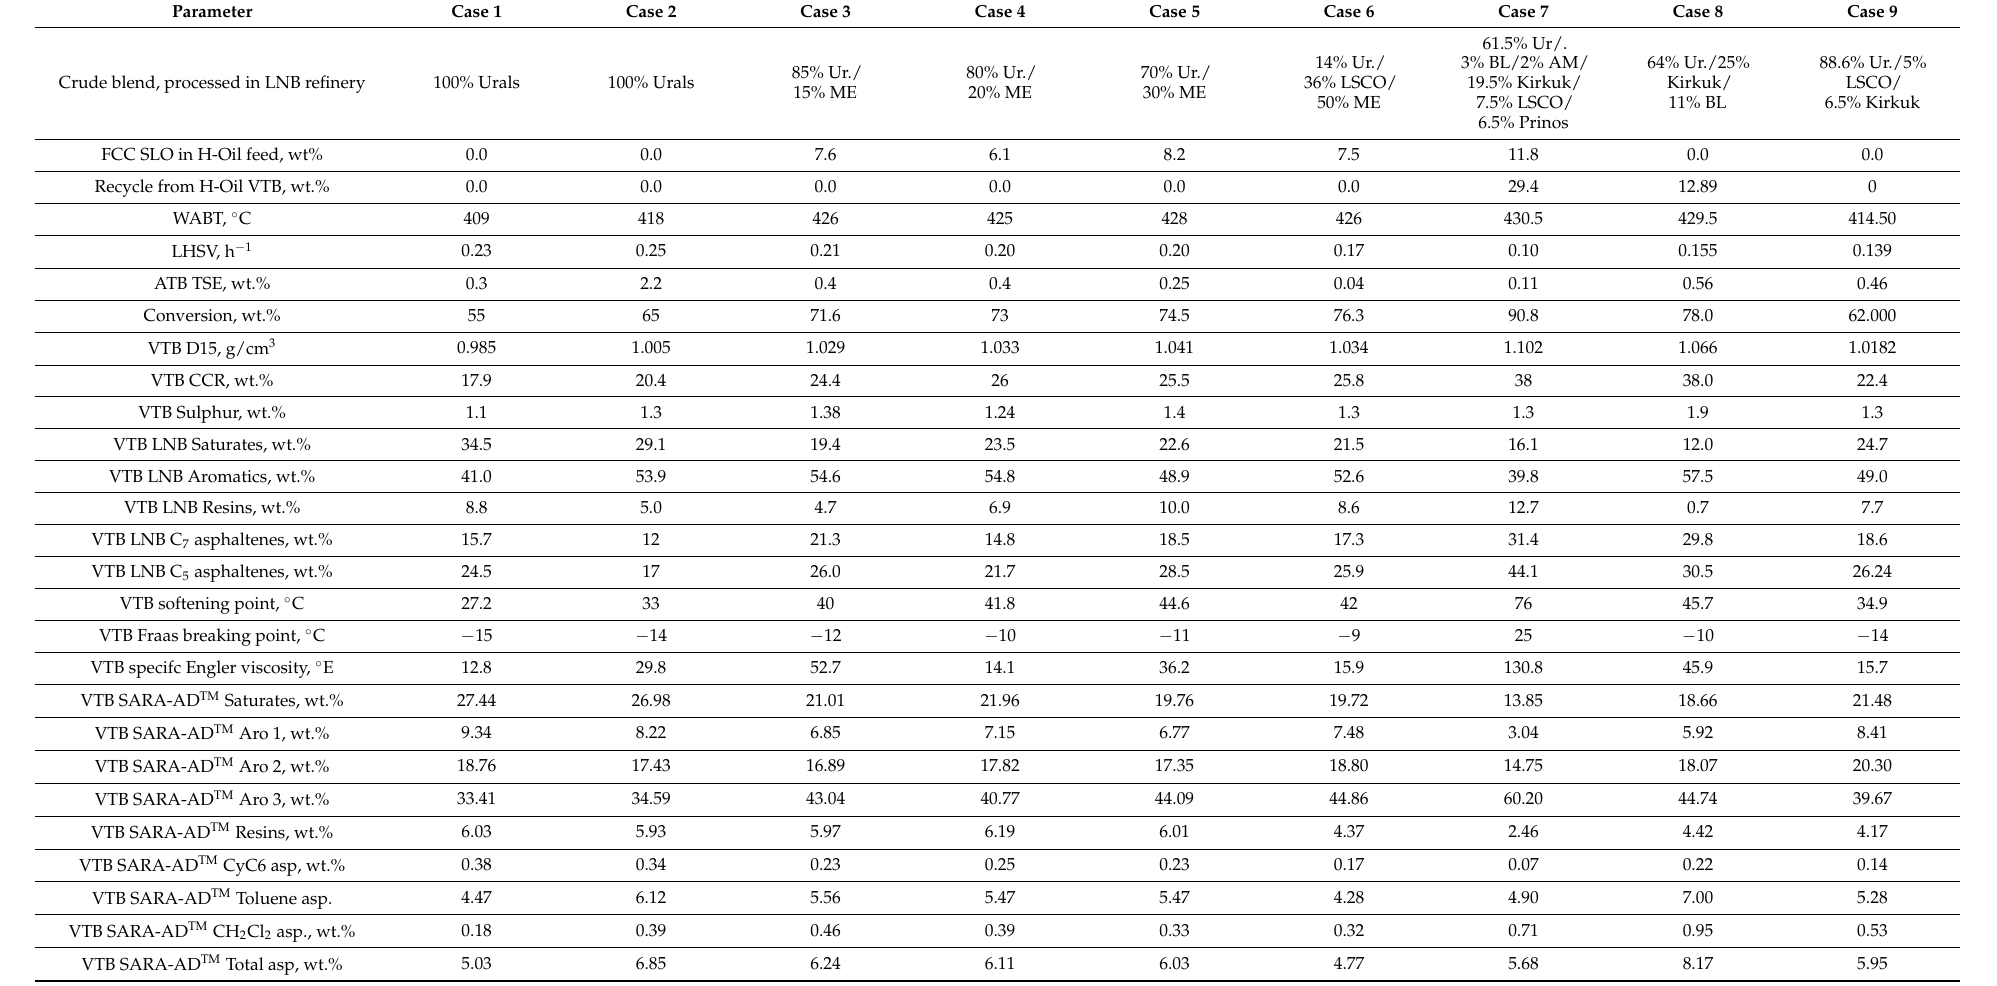
Table 4. H-Oil operating conditions, bulk properties, LNB four fraction SARA, and WRI eight fraction SAR-AD TM composition data of hydrocracked vacuum residues